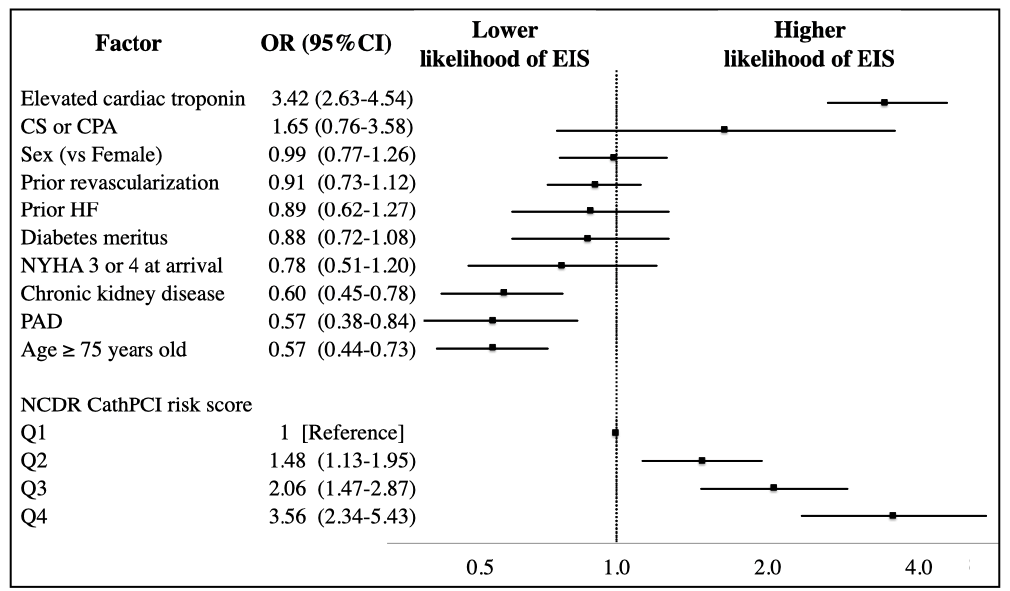
Table 2. In-hospital outcomes.